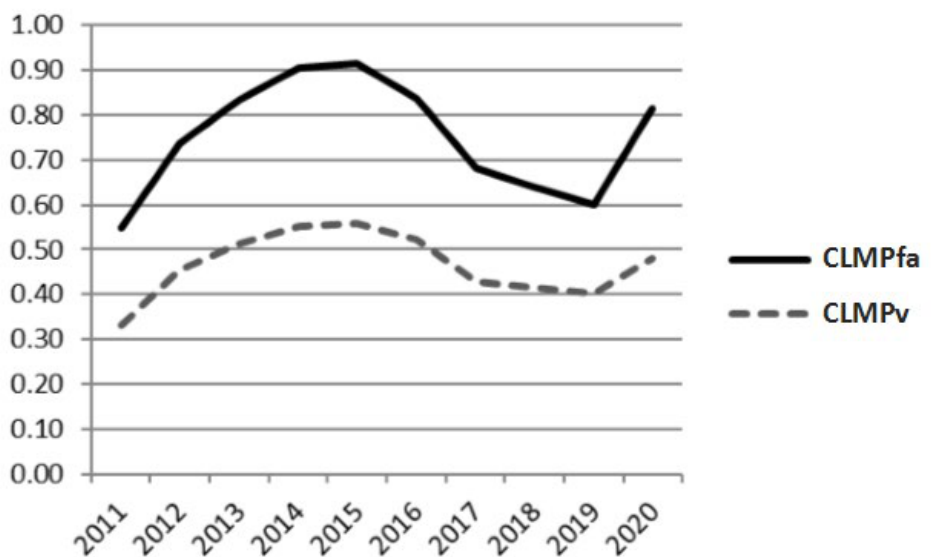
Figure 9. CLMP value dynamic for the PJSC “Severstal”. CLMPfa—CLMP based on the total fixed assets; CLMPv—CLMP based on the total cost of machinery and equipment.